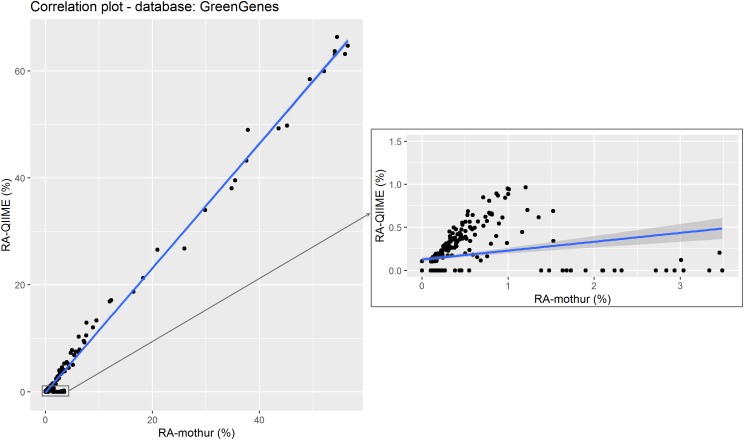
Relative abundance of the different microorganisms (by genera) detected by QIIME and mothur within the 18 samples using GreenGenes as reference data set. The subset shows the correlation between data with QIIME RA < 1%. Points represent individual RA within each sample.